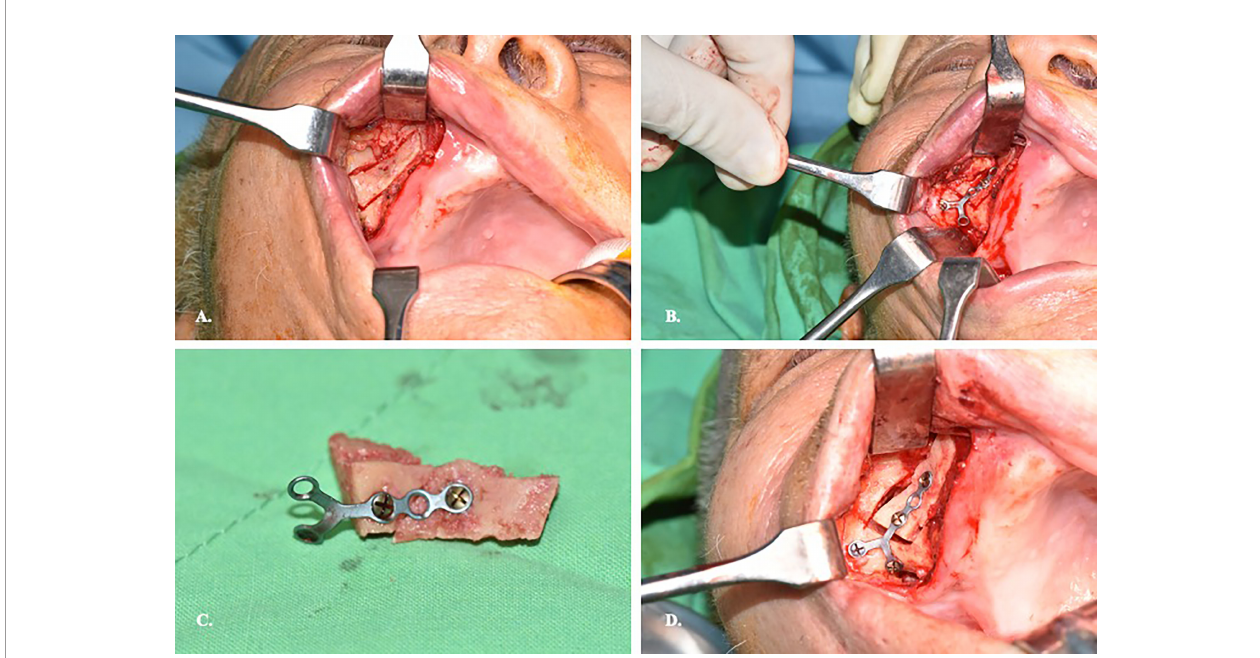
FIGURE 2 | Preparation of the bone window on the anterior wall of maxillary sinus. (A) Supravestibular incision to expose sinus anterior wall. (B) Prebend the miniplate before osteotomy of the sinus wall. (C) Illustration of the miniplate-pre fi x bony wall. (D) Reposition of the bony wall after completion of the orbital surgery.